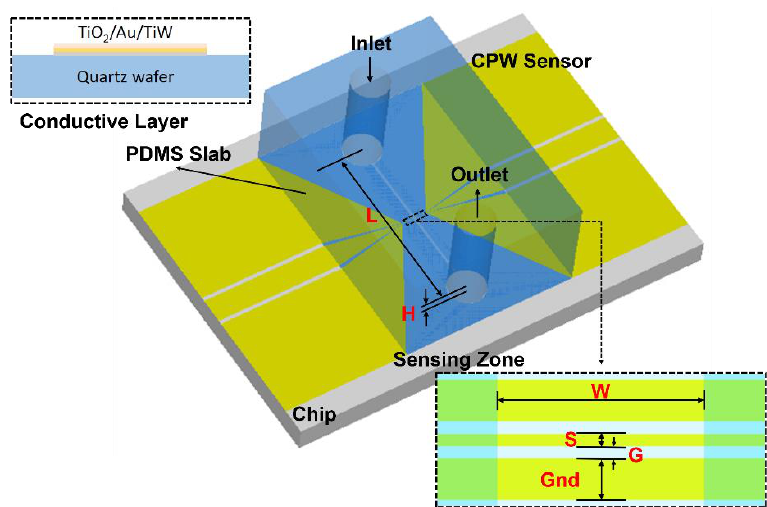
Figure 3. The topology of the tapered CPW sensor structure with microfluidic channel on top and the zoomed-in sensing zone. Topology of the gold coated CPW sensor on quartz chip. The parameters of the sensing CPW lines are S(ignal) = 6 um, G(ap) = 6 um, and Gnd = 20 um, and dimensions of the PDMS liquid channel are L = 7 mm, W = 0.1 mm, and H = 10